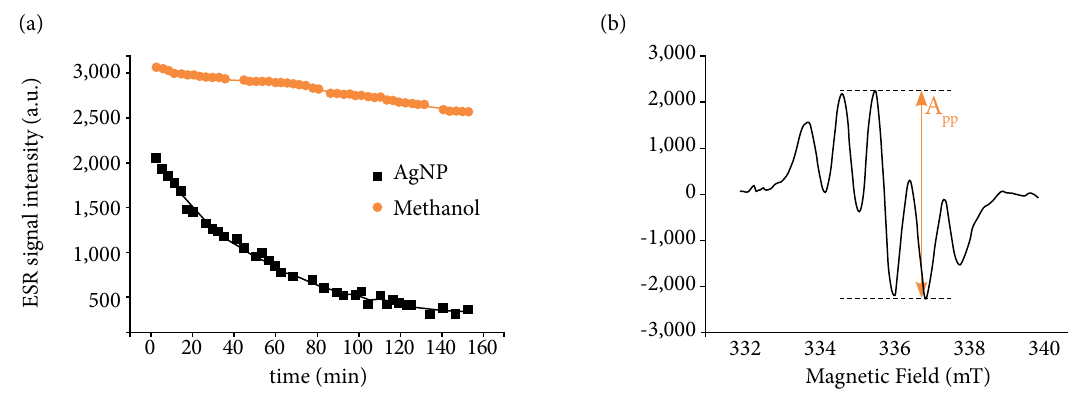
Figure 3 - (a) ESR spectrum of DPPH showing the intensity of the central line. (b) ESR signal intensity of DPPH overtime after the reaction with AgNP and